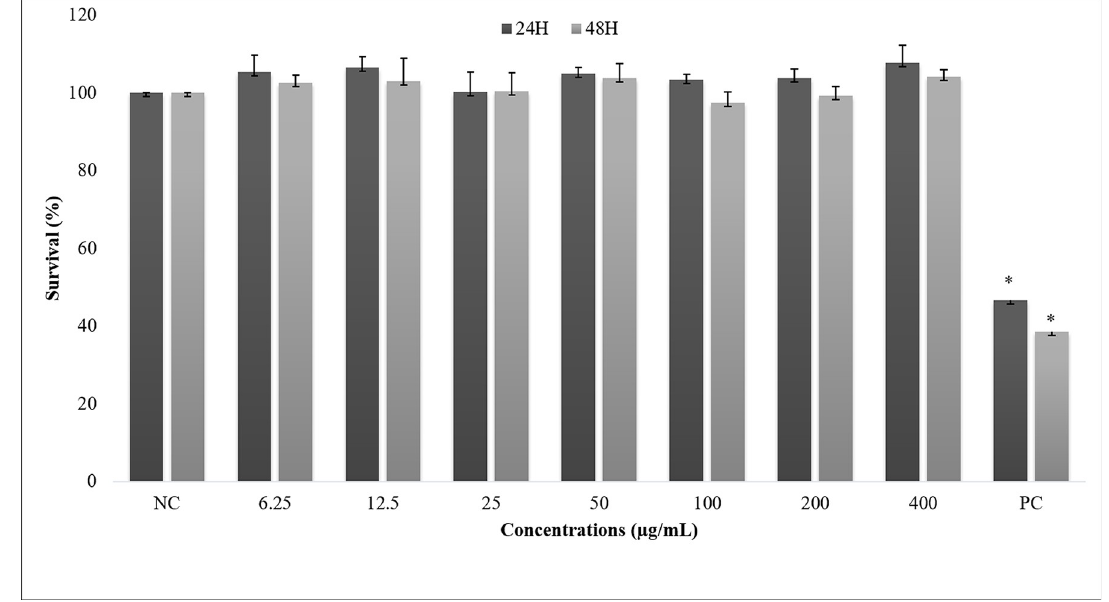
Fig 2. Percentage of average of survival ACP02 cells by exposure to the aqueous ethanol extract of Libidibia ferrea at 24 and 48 hours. ANOVA parametric test; Tukey-Kramer Multiple comparisons (p < 0.05). In which NC means negative control and PC means positive control and � Differs from other treatments.